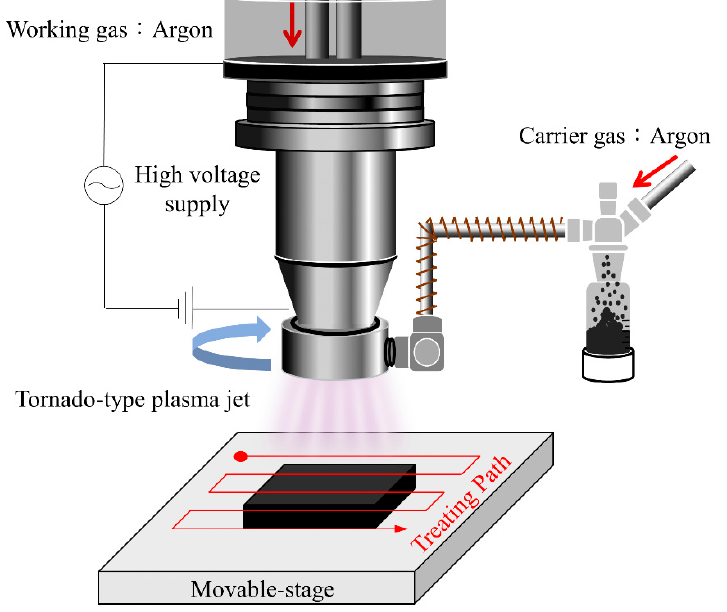
Figure 11. Schematic apparatus of the tornado-type atmospheric pressure plasma coating system.